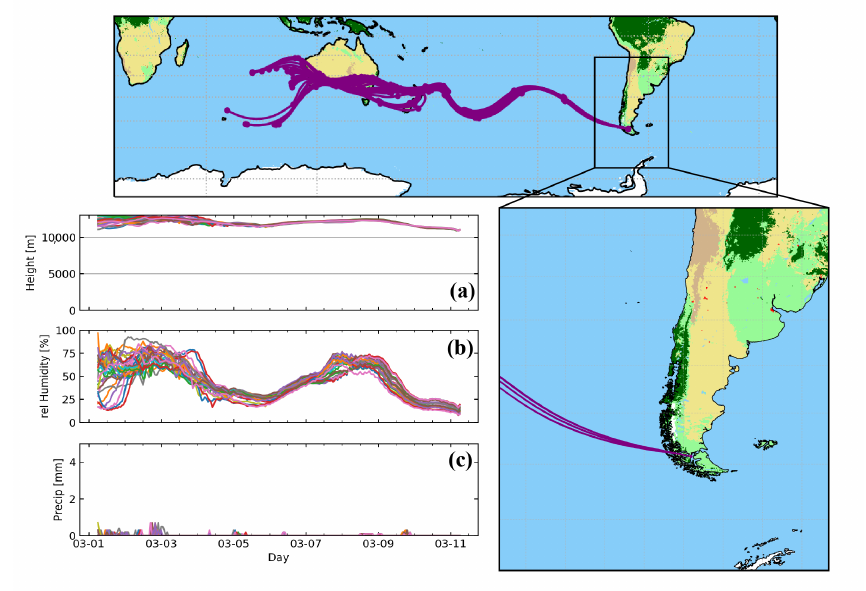
Figure 7. Same as Figure 3 but for 11 March 2019, 06:00 UTC, at 11 km